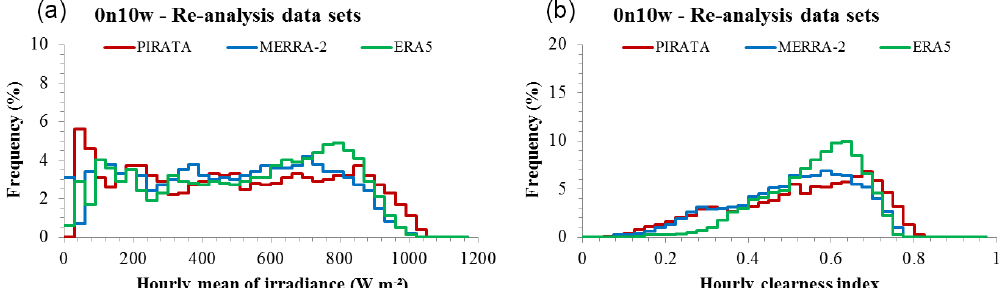
Figure B5. Frequency distributions of PIRATA measurements (red) and data sets (MERRA-2: blue, ERA5: green) at 0 ◦ N, 10 ◦ W for E (a) and KT (b) . If the coloured line is above (below) the red one for a given sub-range of values, it means that the data set produces these values too frequently (too rarely) with respect to the PIRATA